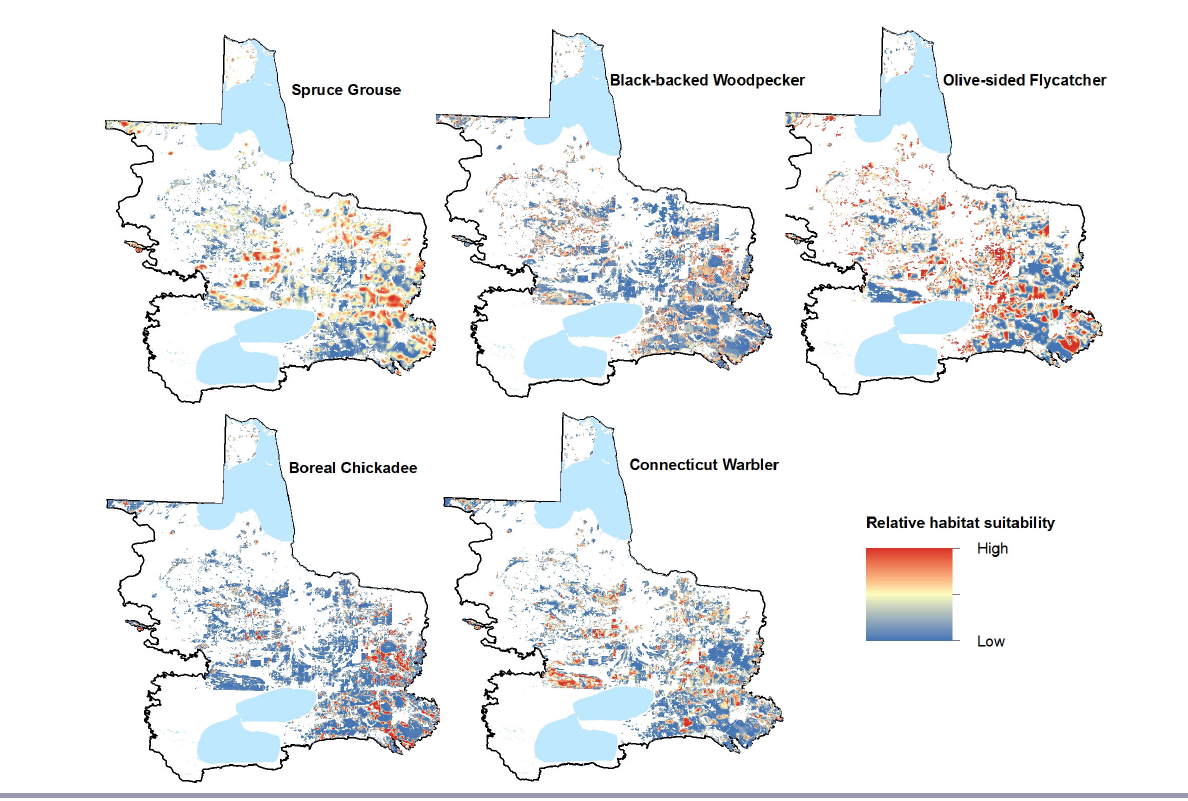
Fig. 2 . Relative habitat suitability index for five boreal bird Species of Greatest Conservation Need breeding in the Agassiz Lowland Subsection of northern Minnesota. Raw MaxEnt output, rescaled to a cumulative index, is presented. Suitability scores should not be compared between species, rather, should be interpreted as a relative scale within each